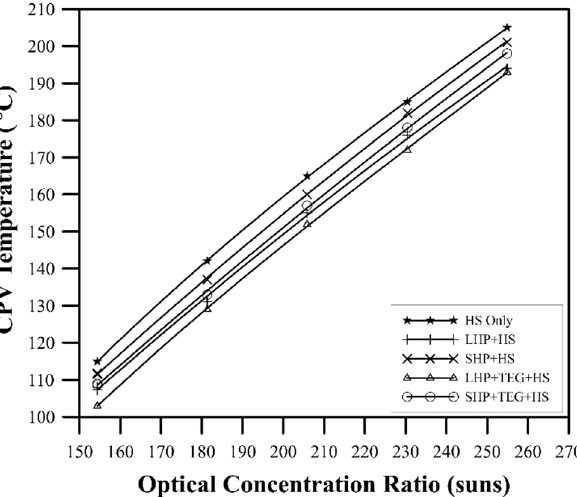
Figure 4. CPV temperature as a function of the optical concentration ratio.